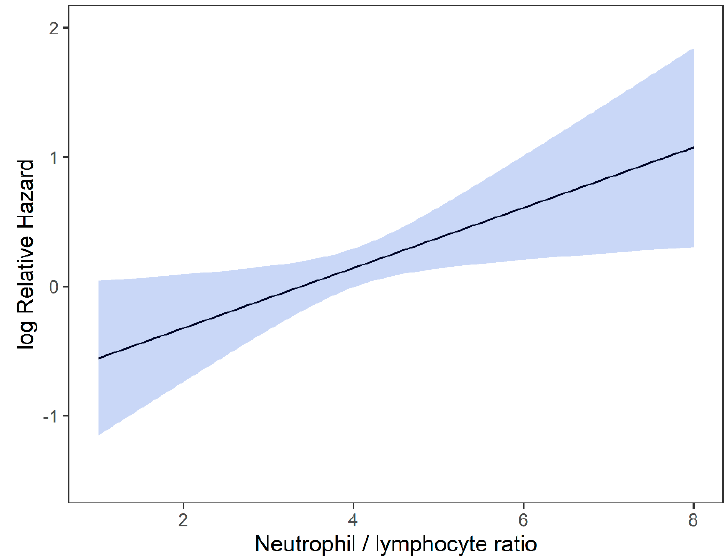
Figure 2. Risk of death by NLR.